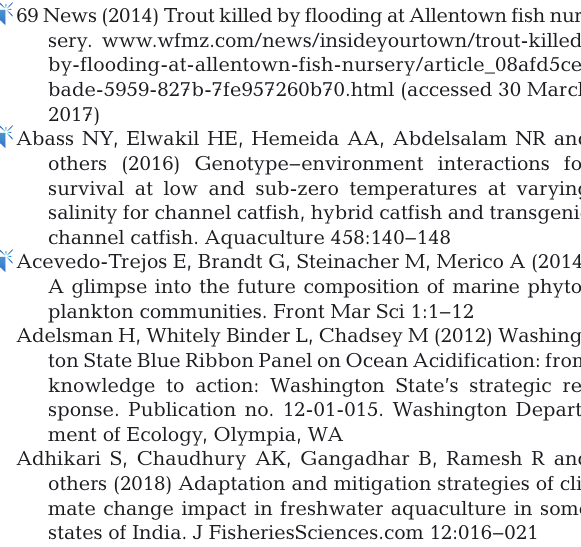
Figueiras FG and others (2008) Renewal time and the impact of harmful algal blooms on the extensive